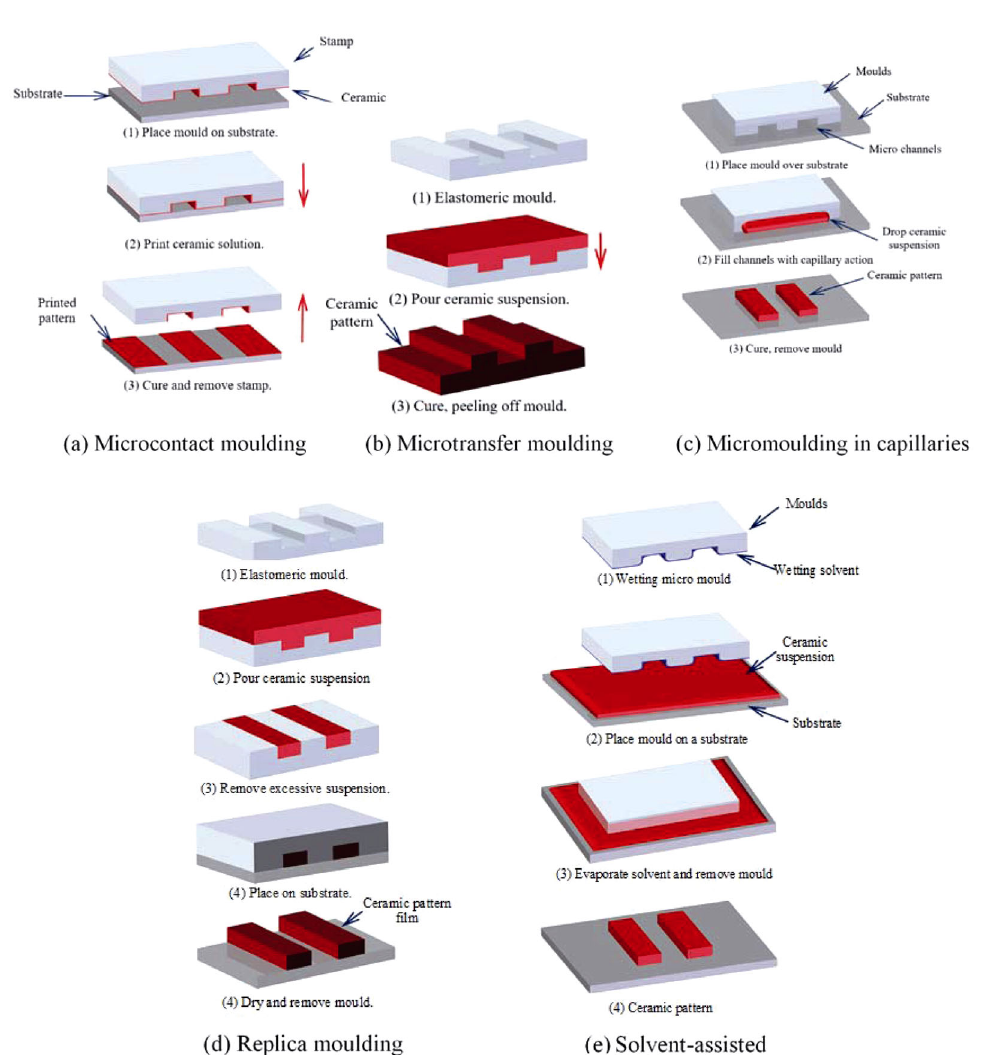
Fig. 23 Soft-lithography techniques. (a) Micro-contact moulding. (b) Micro-transfer moulding. (c) Micro-moulding in capillaries. (d) Replica moulding. (e) Solvent assisted